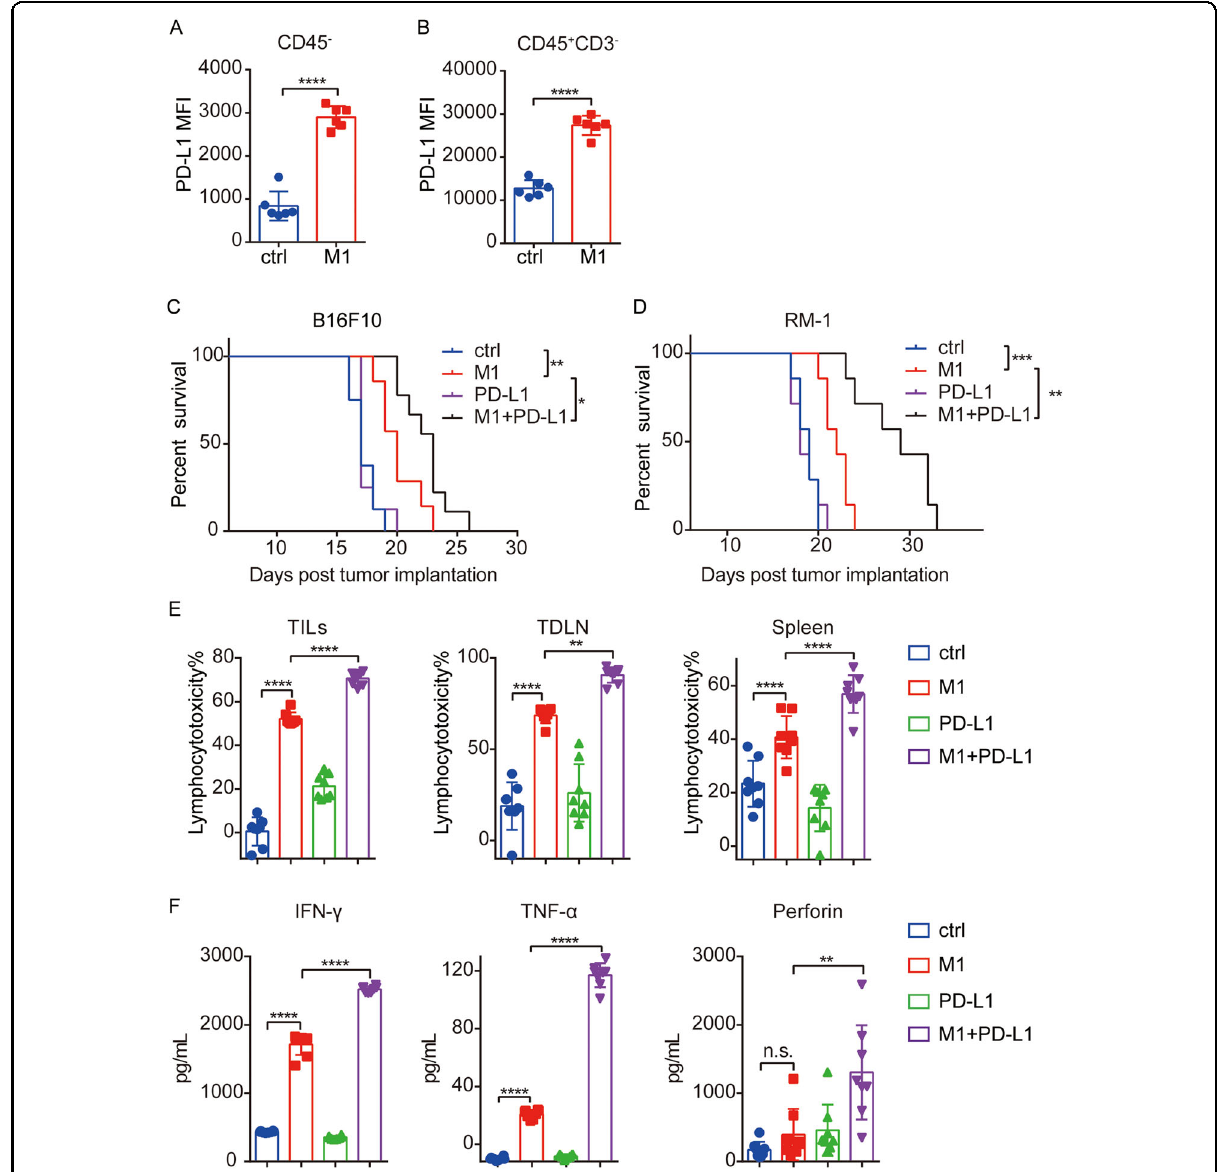
Fig. 6 M1 induces PD-L1 upregulation and overcomes PD-L1 blockade resistance. A , B C57BL/6 mice were implanted subcutaneously in the right fl ank with B16F10 cells on day 0 and treated intravenously with ctrl ( n = 6) or M1 ( n = 6) (1 × 10 7 pfu) once per day on days 6 – 10. The expression of PD-L1 on CD45 − and CD45 + CD3 − cells in tumor tissue samples were detected by fl ow cytometry on day 13. The P value was determined by a two-tailed Student ’ s t test. C C57BL/6 mice were implanted subcutaneously in the right fl ank with B16F10 cells on day 0 and treated intravenously with ctrl or M1 (1 × 10 7 pfu) daily on days 7 – 11. A PD-L1 antibody or isotype control antibody was injected intraperitoneally on days 9, 12, 15, 18, and 21. Kaplan – Meier survival curves (right) are shown. ctrl, n = 8; M1, n = 7; PD-L1, n = 8; M1 + PD-L1, n = 9. The P value was determined by the log-rank test. D C57BL/6 mice were implanted subcutaneously in the right fl ank with RM-1 cells on day 0 and treated intravenously with ctrl or M1 (1 × 10 7 pfu) once per day on days 6 – 10. The PD-L1 antibody or isotype control was injected intraperitoneally on days 8, 11, 14, 17, and 20. Kaplan – Meier survival curves (right) are shown. n = 7. The P value was determined by the log-rank test. E Tumor models were established, and M1 plus PD-L1 antibody treatment was conducted as shown in ( C ). Lymphocytes isolated from B16F10 tumor tissue samples (TILs), tumor-draining lymph nodes (TDLN), and the spleen on day 15 were cocultured with B16F10 cells for 48 h to evaluate cytotoxicity. n = 8. The P value was determined by one-way ANOVA with Dunnett ’ s test. F IFN- γ , TNF-a, and perforin were analyzed in supernatants of splenic lymphocytes cocultured with B16F10 cells. n = 8. The P value was determined by one-way ANOVA with Dunnett ’ s test. Data are shown as the mean ± SD. * P < 0.05; ** P < 0.01; *** P < 0.001. **** P < 0.0001. See also Supplementary Fig.